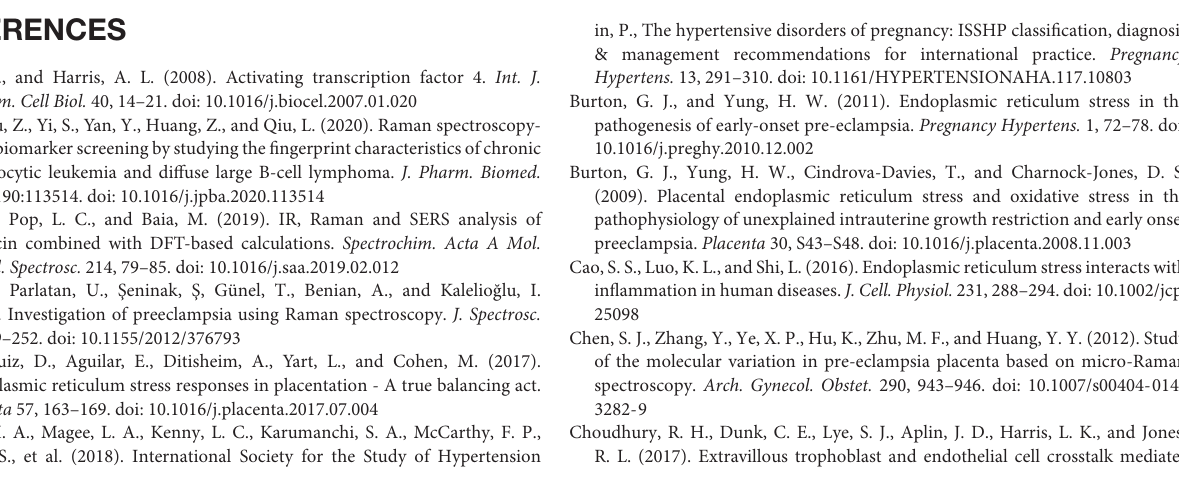
Supplementary Figure 1 | Raman spectral changes in preeclamptic serum. (A) Main Raman spectra from control (NPE) and preeclamptic (PE) serum with the most variable bands. (B) Three-dimensional PCA score plot. (C) Raman intensity from the bands: 629, 724, 966, 1,152, 1,175, 1,201, 1,452, 1,514, 1,525, 1,535, 1,660, and 1,668 cm − 1 . Bar graphs represent mean values ± S.E.M. ∗ p < 0.05, ∗∗ p < 0.01, ∗∗∗ p <